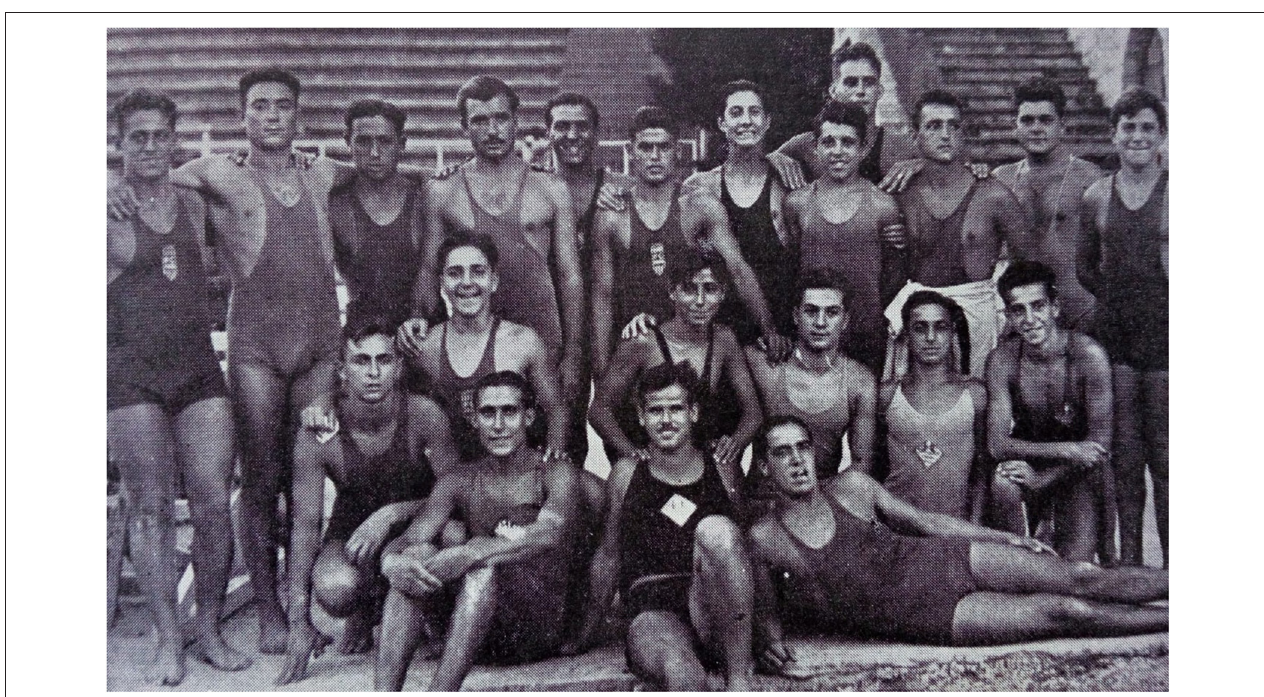
FIGURE 2 | Antonio Cánovas (standing fifth from right) and his BAC teammates (1935). Source: Cánovas family